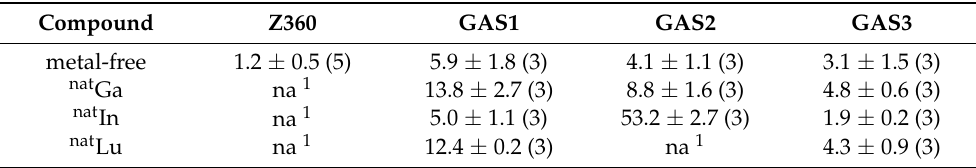
Table 1. Receptor affinities Z360 and its analogs as determined during competition assays